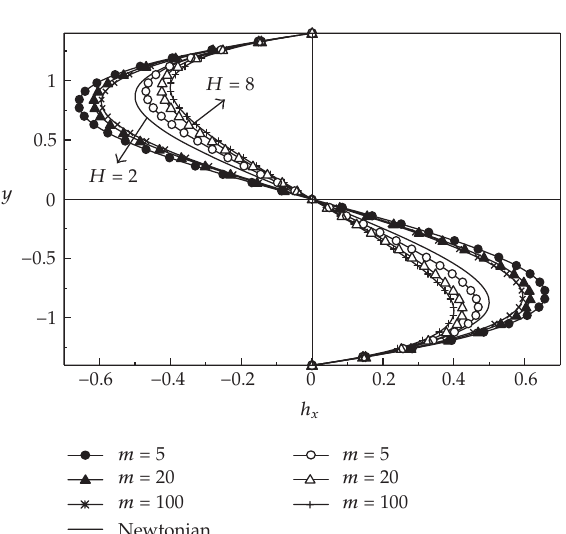
Figure 7: Variation of the axial-induced magnetic field across the channel for α (cid:8) 0 . 4 , θ (cid:8) 1 . 2 , N (cid:8) 0 . 9 , R m (cid:8) 1, and di ff erent values of m and H .